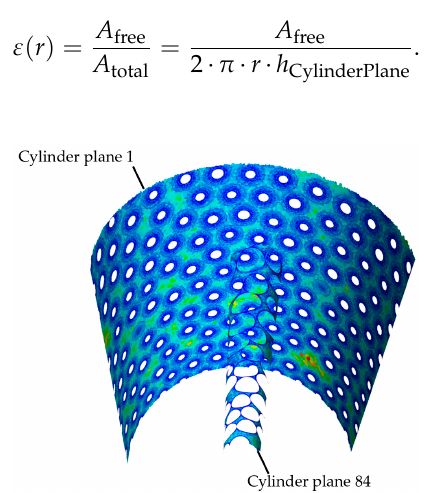
Figure 3. Cylindrical planes for calculation of radial porosity and velocity profiles.